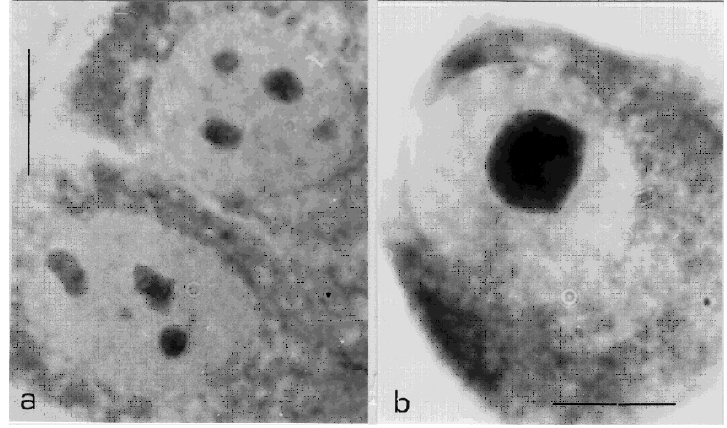
Fig. 1. Cells exhibiting well discriminated nucleoli in preparations stained according to Mello et al.’s [15] procedure. A situation of extreme contrast as regards number and size of nucleoli was purposedly chosen. (a) MCF-10F control cell; (b) BP1-T ras cell. Bar = 10 µ